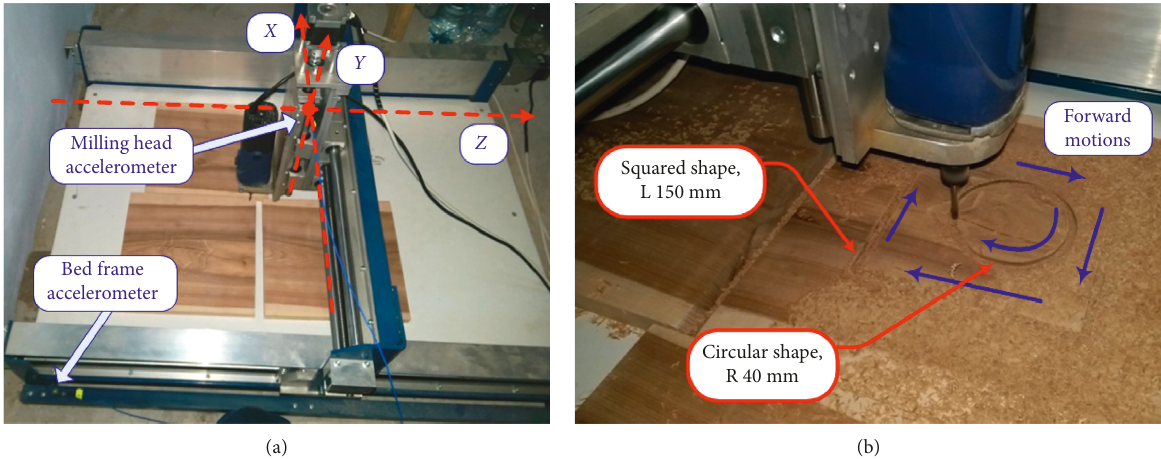
Figure 1: The general view of the experimental setup (a) with indication of measurement points and vibration monitoring directions and, respectively, a detailed view of the milling area (b) containing examples of milling